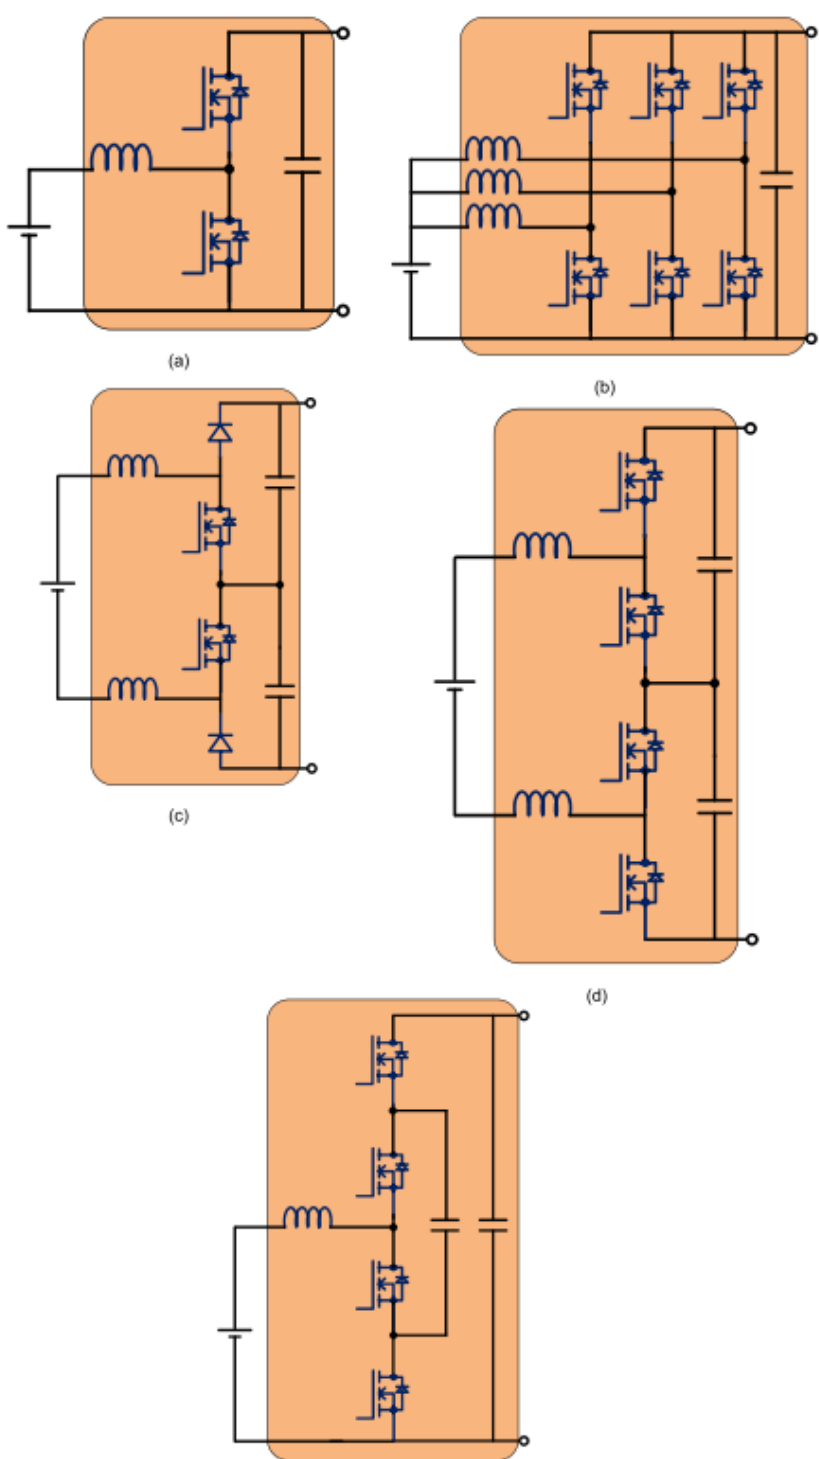
Figure 8. Non ‐ isolated DC ‐ DC converter topologies for DCFCs: ( a ) boost converter; ( b ) interleaved Figure 8. Non-isolated DC-DC converter topologies for DCFCs: ( a ) boost converter; ( b ) interleaved boost converter; ( c ) unidirectional three ‐ level boost converter; ( d ) bidirectional three ‐ level boost boost converter; ( c ) unidirectional three-level boost converter; ( d ) bidirectional three-level boost converter; ( e ) three-level flying capacitor converter (Reprinted from Ref. converter; ( e ) three ‐ level flying capacitor converter. (Reprinted from Ref. [8].)